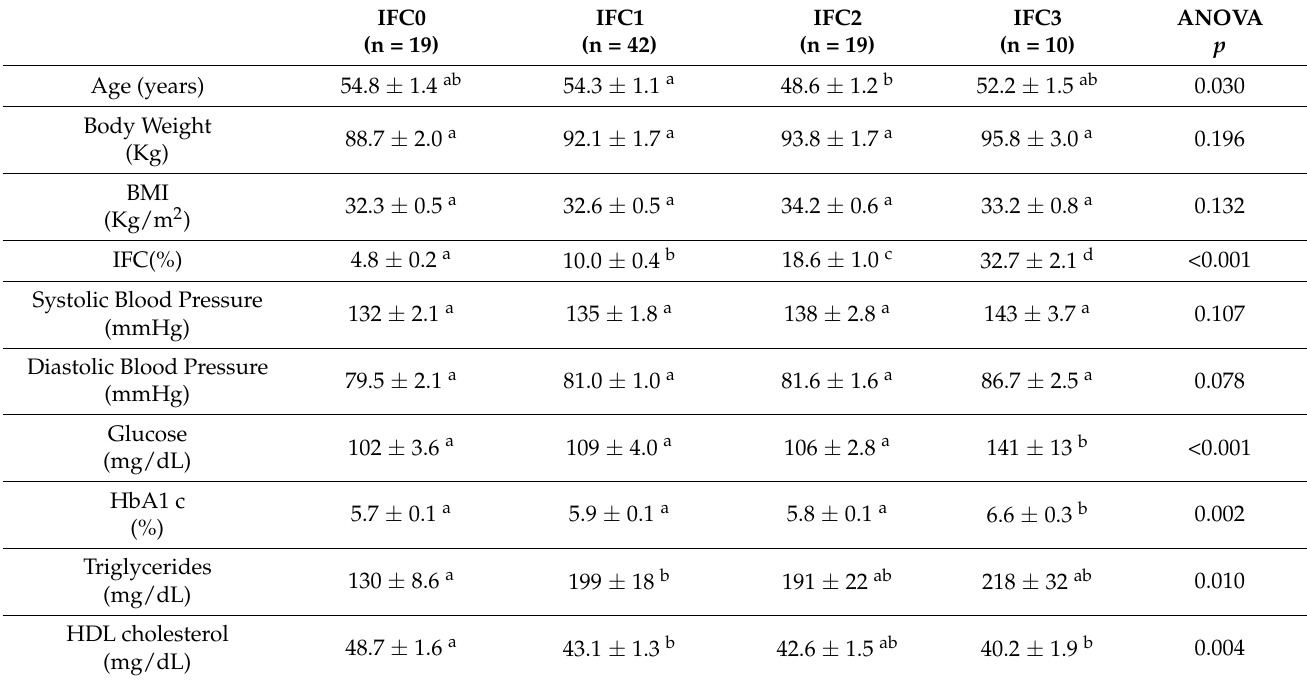
Table 1. Anthropometric, diagnostic and biochemistry parameters of the non-alcoholic fatty liver disease